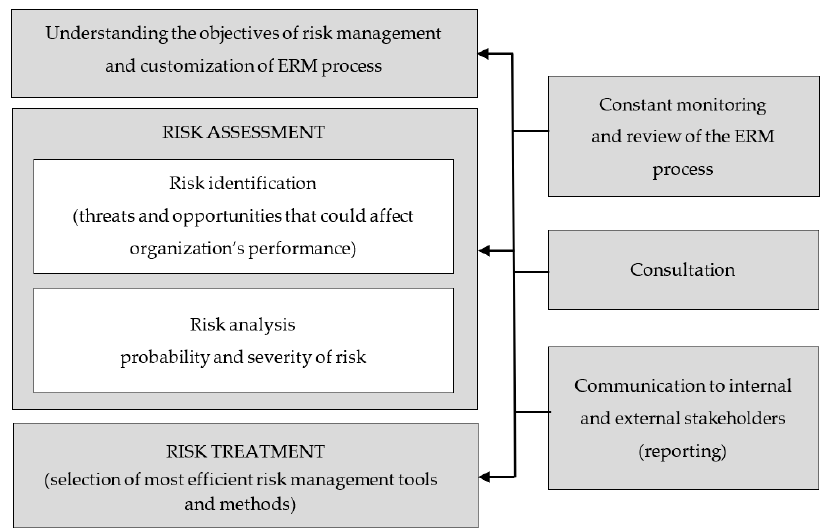
Figure 3. The key stages of the enterprise risk management (ERM) process in accordance with ISO 31000. Source: own study based on ISO 31000:2018 2018.